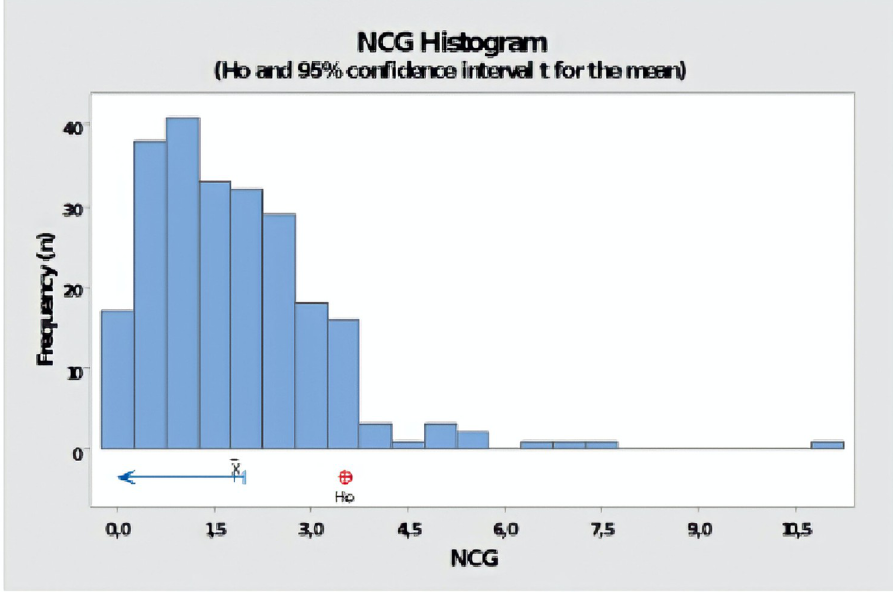
Fig 4. Histogram for NCGs concentration (Ho and 95% CI) for processes using WFI for steam generation.